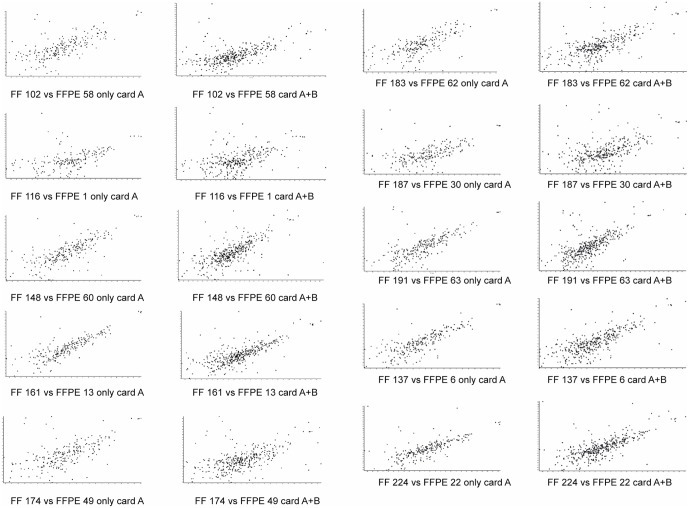
Correlation of paired samples visualized on scatterplots.Scatter plots of the normalized RQ values in pair-wise comparison from fresh-frozen (FF) and formalin-fixed paraffin embedded (FFPE) samples.